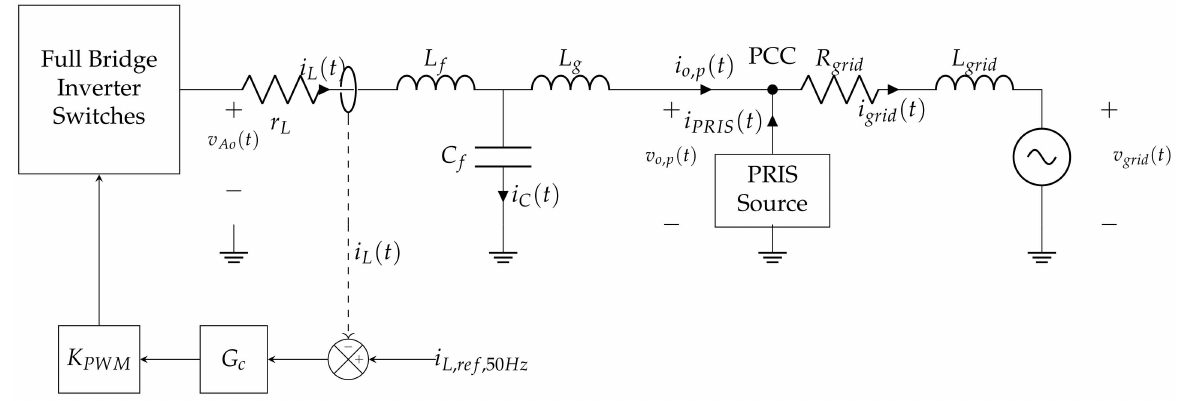
Figure 4. The inverter with the PRIS perturbation source connected at its AC output